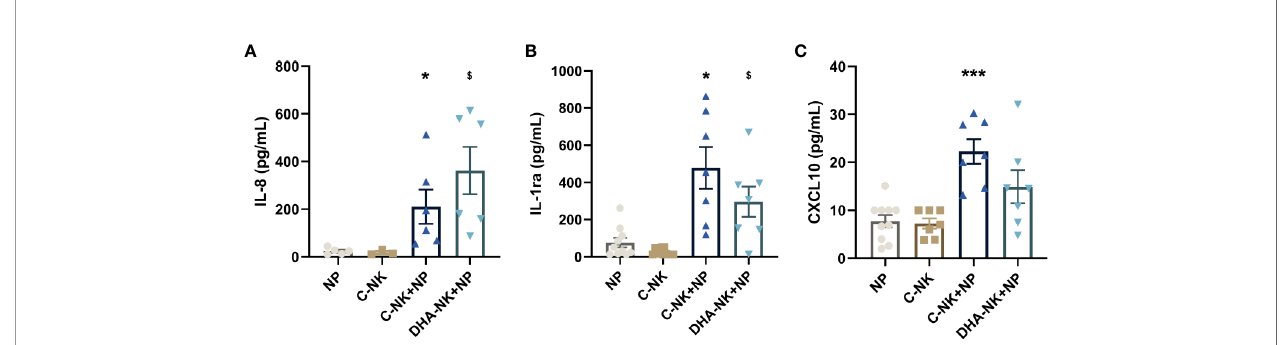
FIGURE 2 | The effects of NK cells and NK cells pre-incubated with DHA on neutrophil production of IL-8 (A) , IL-1ra (B) , and CXCL10 (C) . Neutrophils (NP) and NK cells (C-NK) were cultured alone or together after the NK cells had been pre-incubated for 18 h without (C-NK+NP) or with 50 µM docosahexaenoic acid (DHA-NK +NP) and then stimulated with IL-2 (2 ng/ml), IL-12 (2 ng/ml), and IL-15 (10 ng/ml). The cells were cultured together for 18 h. Cytokine concentrations in supernatants were determined by ELISA and are presented as pg/ml. Data are shown as mean ± SEM; * indicates difference between C-NK+NP and NP, and $ difference between DHA-NK+NP and NP. One symbol indicates p < 0.05 and three symbols p < 0.001. One outlier was removed from the NP group in A and B and one outlier in the C-NK group in C. n = 5 - 11 (except for C-NK in A, n = 3), collected in 4 independent experiments. In Supplementary Figure 2 all outliers are